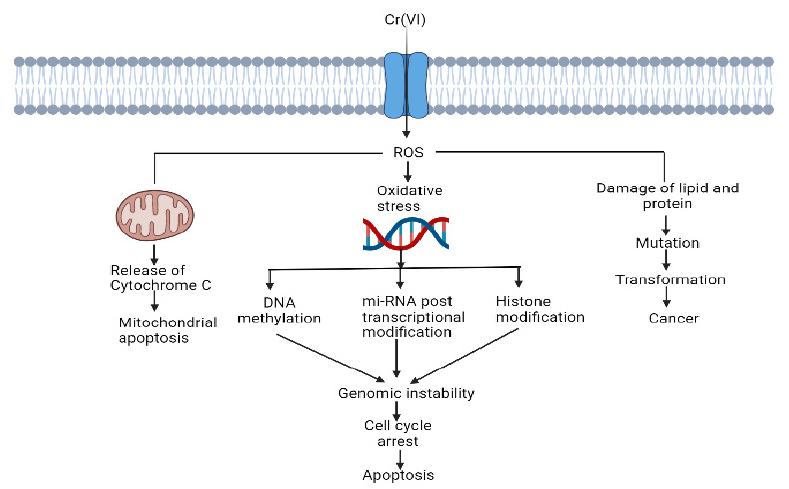
Figure 3. Cr (VI)-induced ROS generation and their role in the disruption of cell organelles.